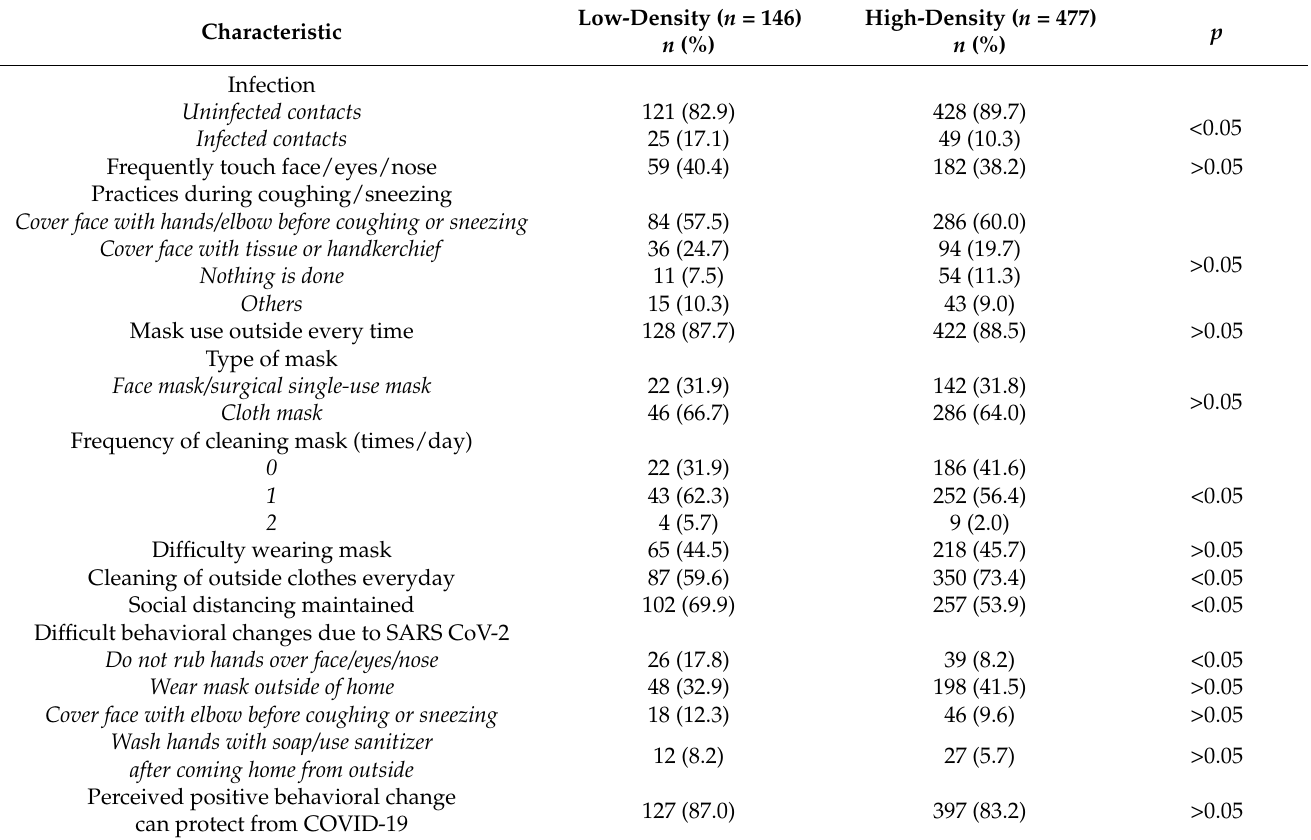
Table 5. Comparison of behavioral change of neighborhood contacts in low-density and high- density areas.